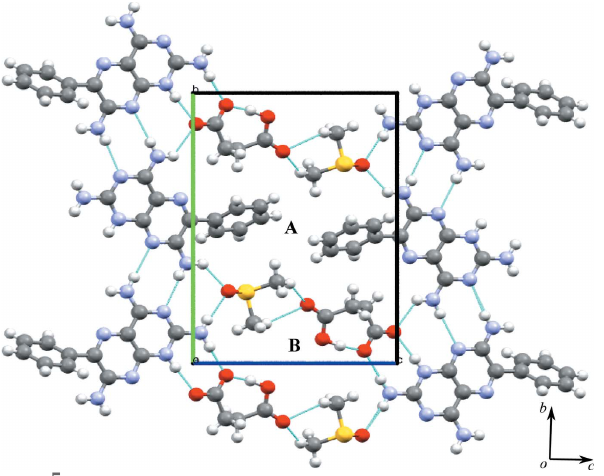
Figure 5 The cyclic hydrogen-bonded networks A and B of the crystal structure of 1b (cid:3) DMSO.